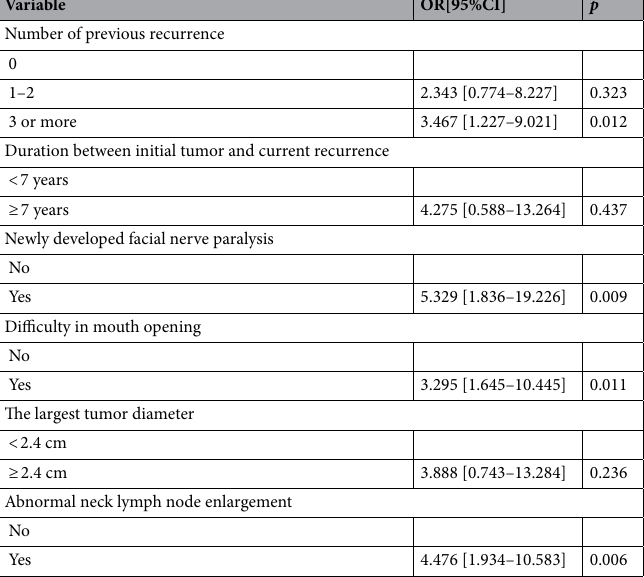
Table 2. Multivariate analysis of the association between preoperative data and malignant transformation